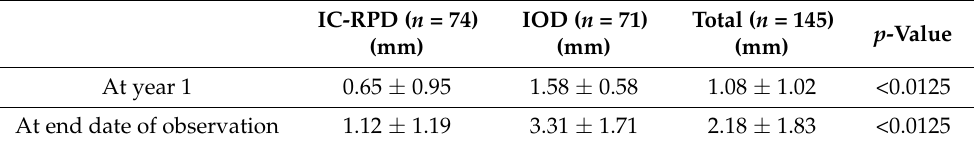
Table 5. Marginal bone loss (MBL) of implants in IC-RPD and IOD at year 1 and at end date of